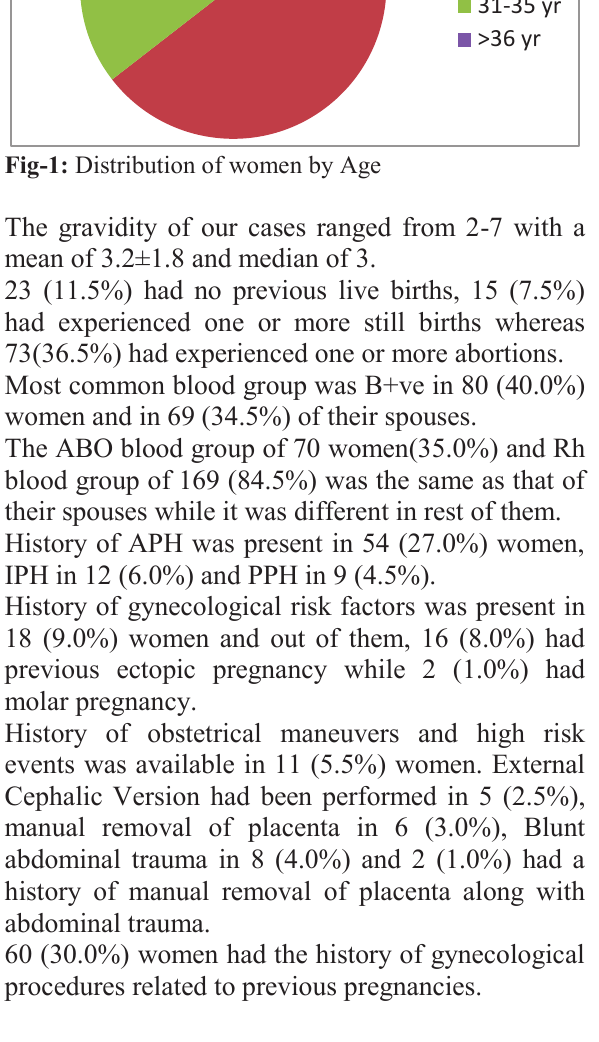
Fig-1: Distribution of women by Age